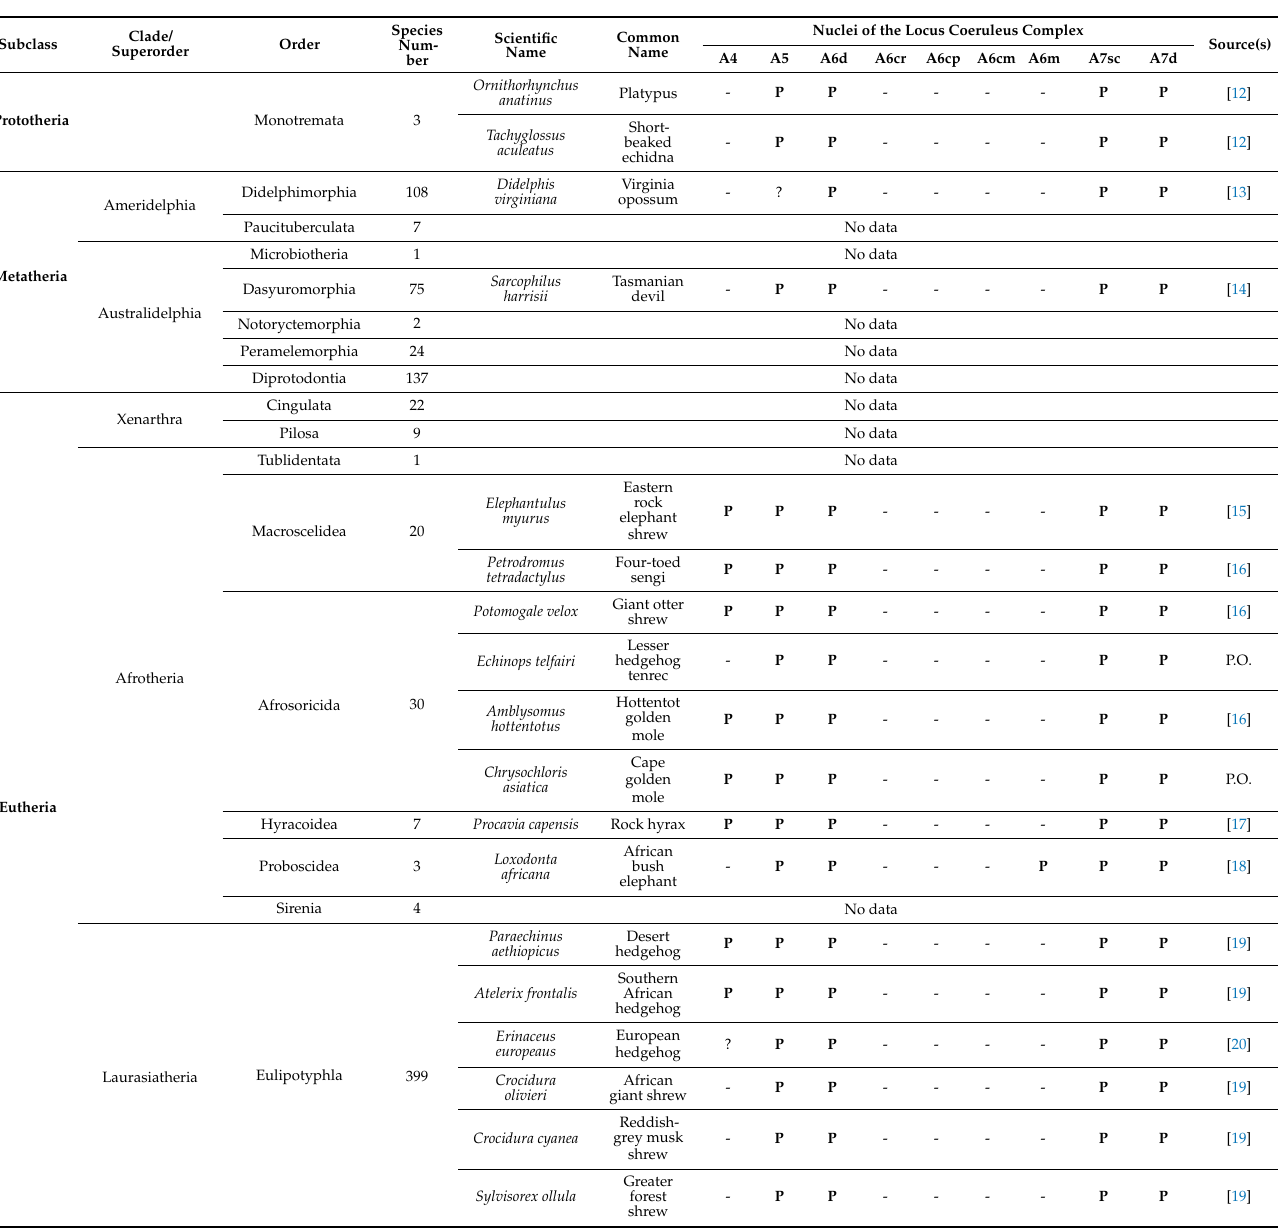
Table 1. The nuclear parcellation of the locus coeruleus complex has been described in approximately 80 mammalian species, representing species across the phylogenetic breadth of this class. This table summarizes the results of the studies where the nuclei have been described and the results, as well as indicating where data is unavailable (No data). A4 —dorsomedial division of locus coeruleus; A5 —fifth arcuate nucleus; A6d —diffuse portion of locus coeruleus; A6cr —compact portion of locus coeruleus, rodent-type; A6cp —compact portion of locus coeruleus, primate-type; A6cm —compact portion of locus coeruleus, megachiropteran-type; A6m —medial division of locus coeruleus; A7sc —nucleus subcoeruleus, compact portion; A7d —nucleus subcoeruleus, diffuse portion; P —nucleus present; —-nucleus absent; P.O.—personal observation, ?—data